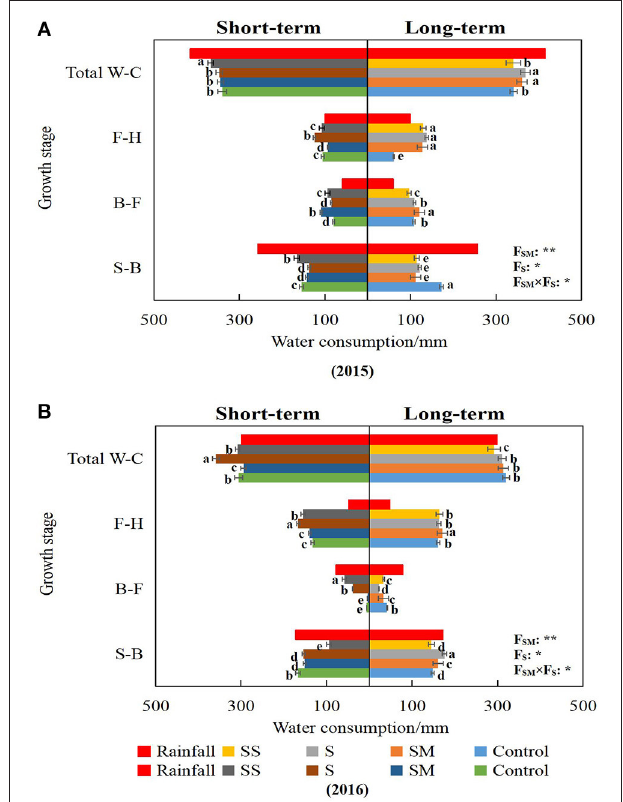
FIGURE 6 | Water consumption in different growth stages of maize under the Control, SM, S and SS treatments in different years. Error bars represent standard deviation ( n = 3). Columns labeled with different letters represent significant differences at P < 0.05 among treatments of two experiments at same growth stage. (A) 2015 and (B) 2016. Control, conventional tillage; SM, straw mulching; S, subsoiling; SS, subsoiling + straw mulching. S-B, sowing-big bellmouth; B-F, big bellmouth-filling; F-H, Filling-harvest; W-C, total water consumption. F SM , F S and F SM × F S mean F-values of straw mulching, subsoiling and their interactions in variance analysis respectively. “* and **” indicate difference at the 0.05 and 0.01 probability levels,